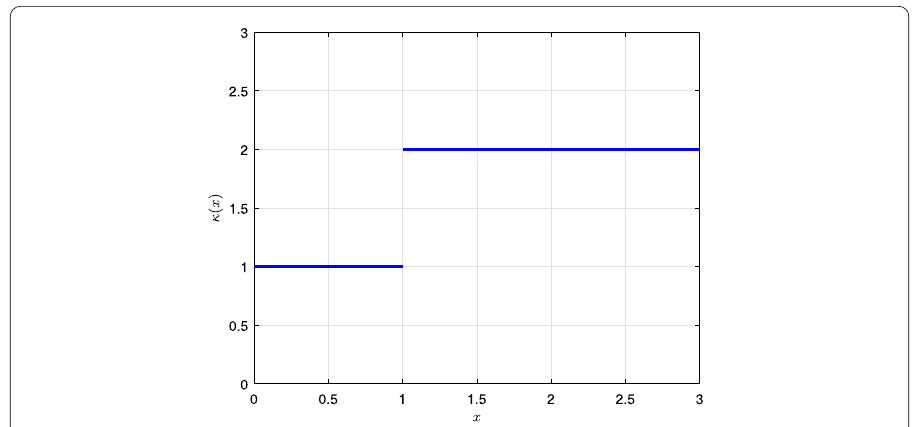
Figure 4 A piecewise constant κ ( x ) Plot of the piecewise constant κ ( x ) function